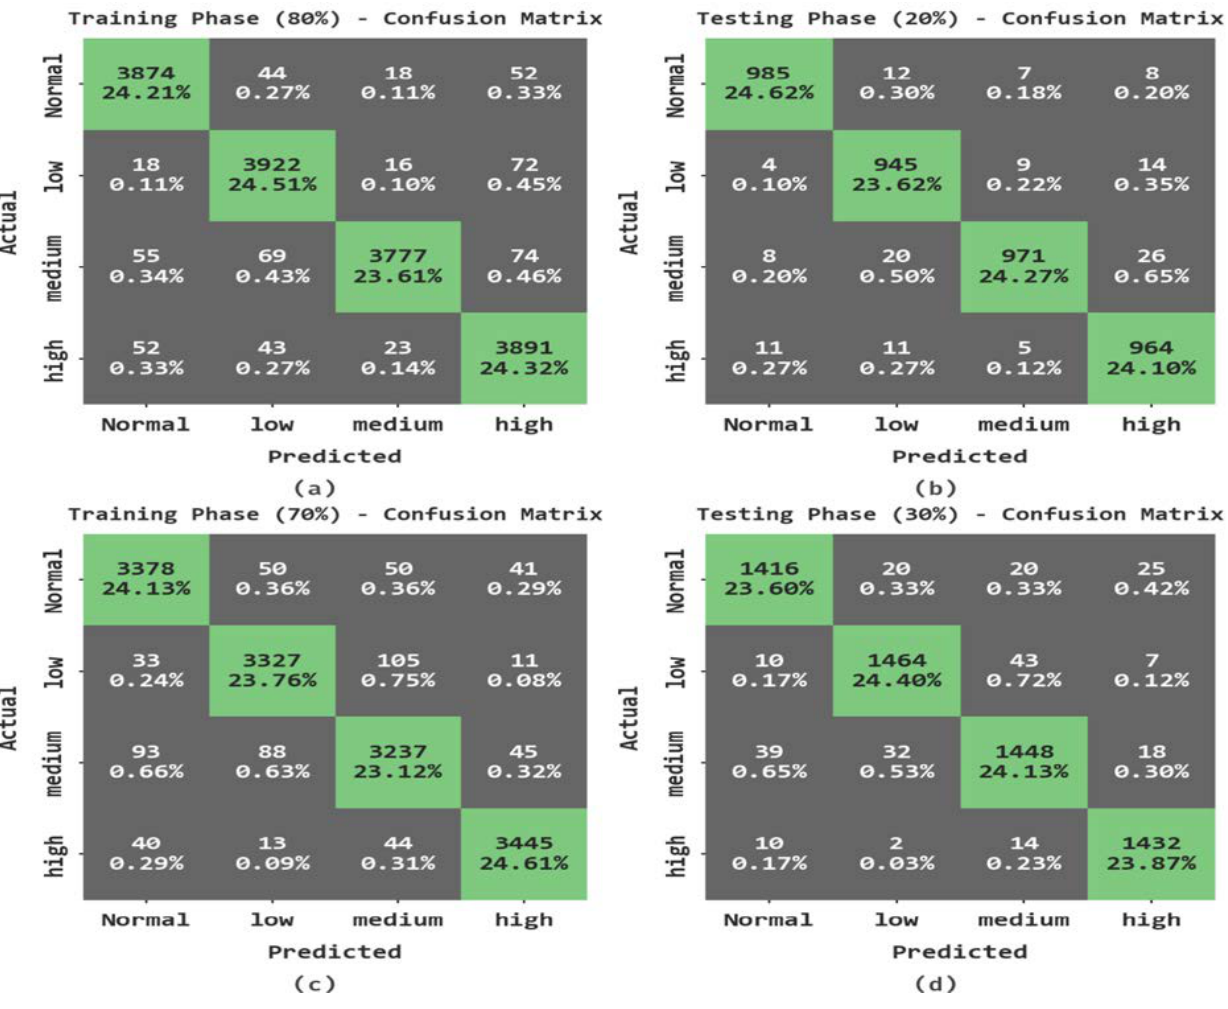
Figure 6. PSNR analysis of the PPIE-ODLASC system under distinct images.